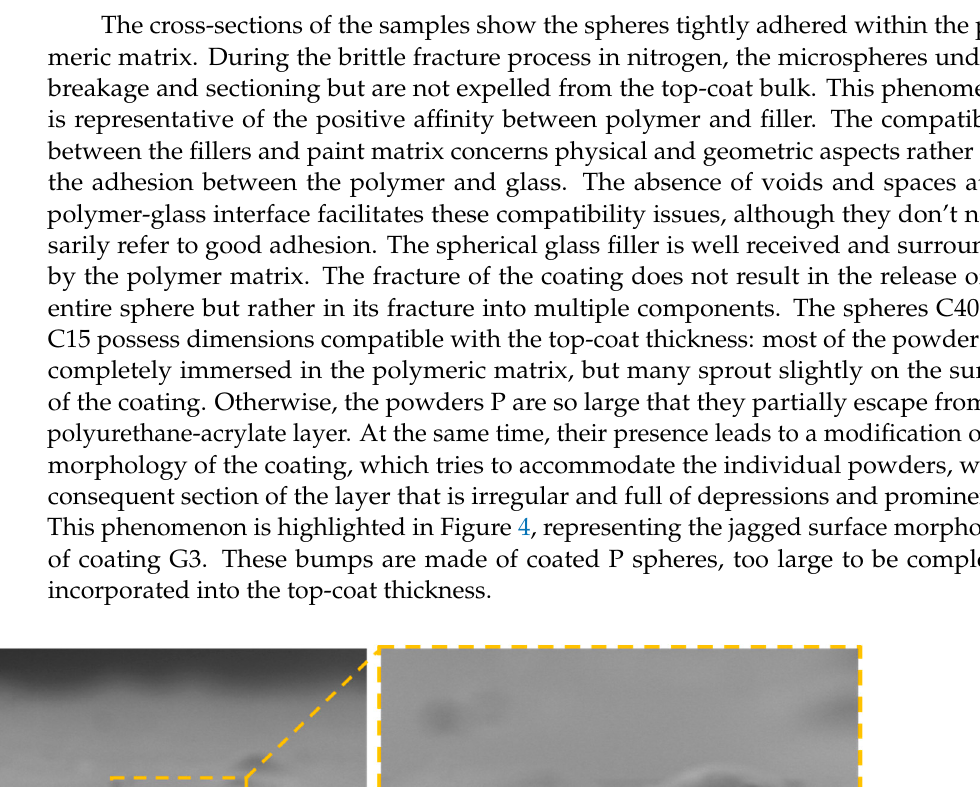
Table 2. Coatings surface roughness. Sample